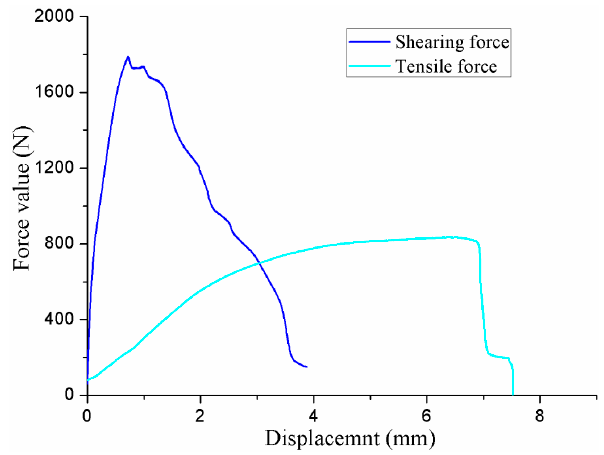
Figure 16. Shearing and tensile force-displacement curves of the improved clinched